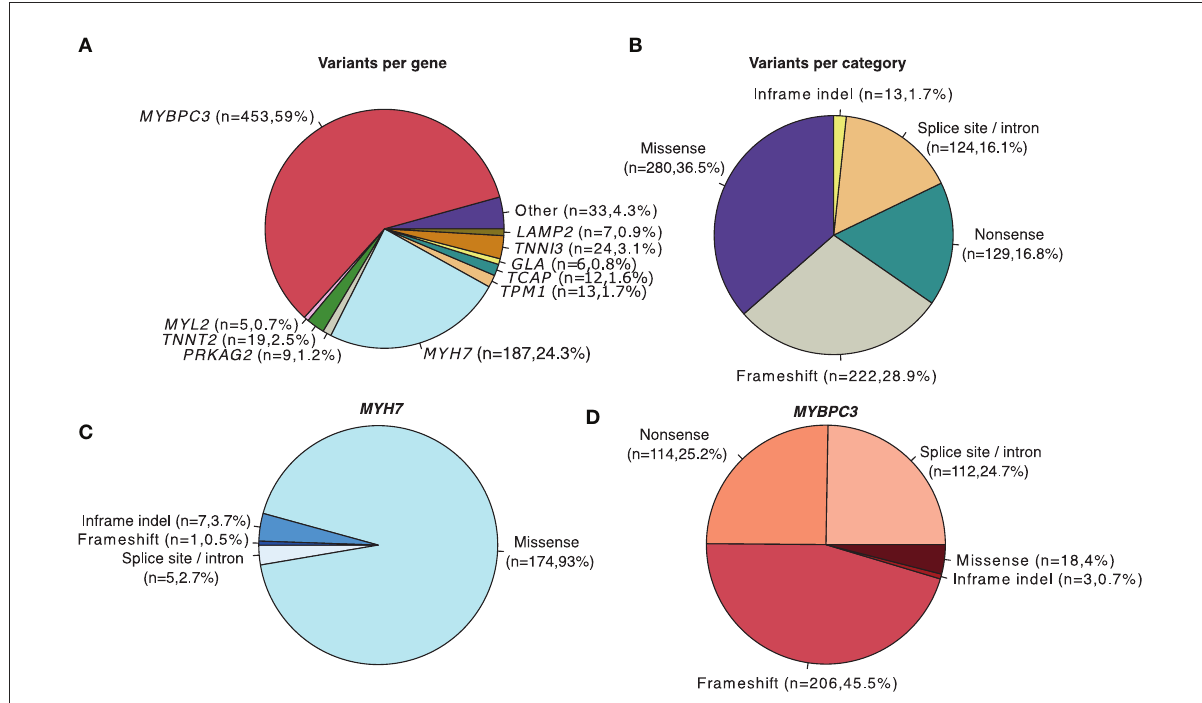
FIGURE1 Distribution of HCM-associated variants (Pathogenic/Likely pathogenic) with a review status of > 1 star in ClinVar ( N proportion of overall variants per gene. (B) Number and proportion of overall variants per category. (C) Category of variants located in the MYH7 gene. (D) Category of variants located in the MYBPC3